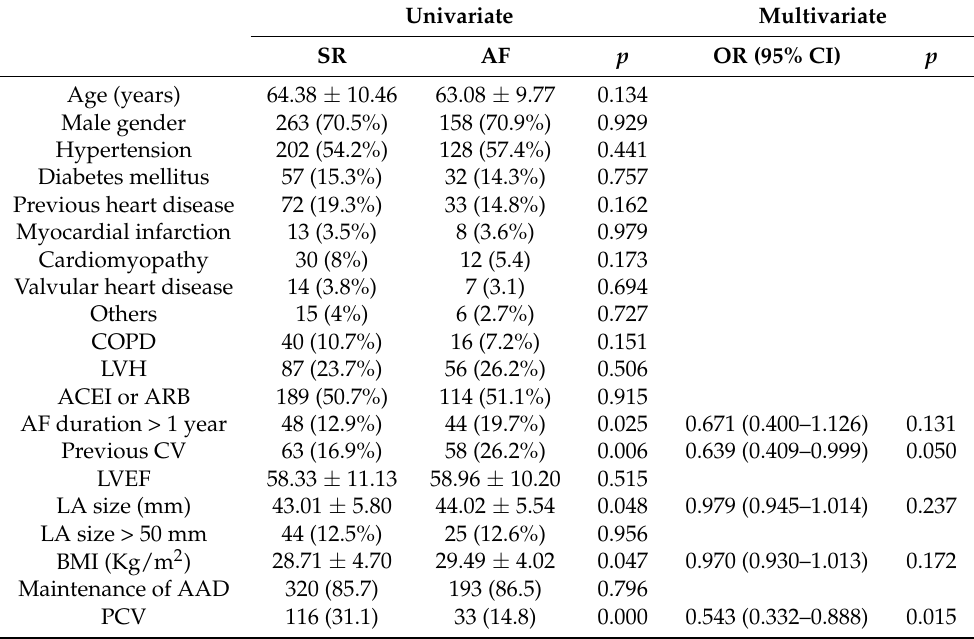
Table 2. Parameters associated with sinus rhythm maintenance at 3 months in univariate and multivariate